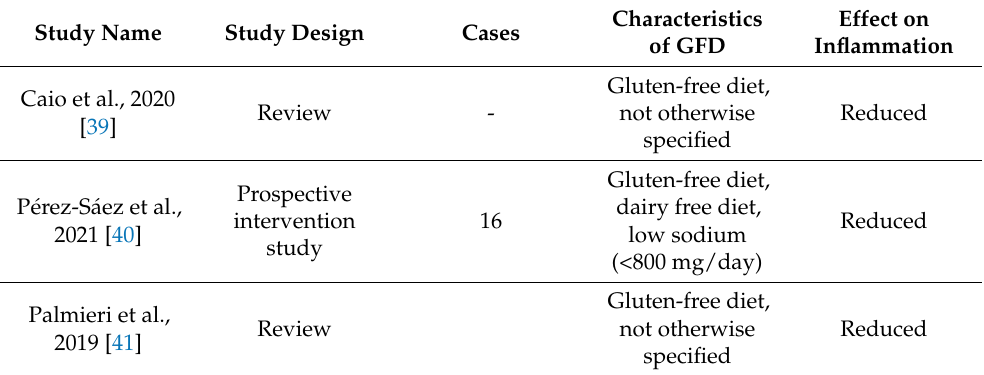
Table 2. Studies about the effects of inflammation on subjects treated with